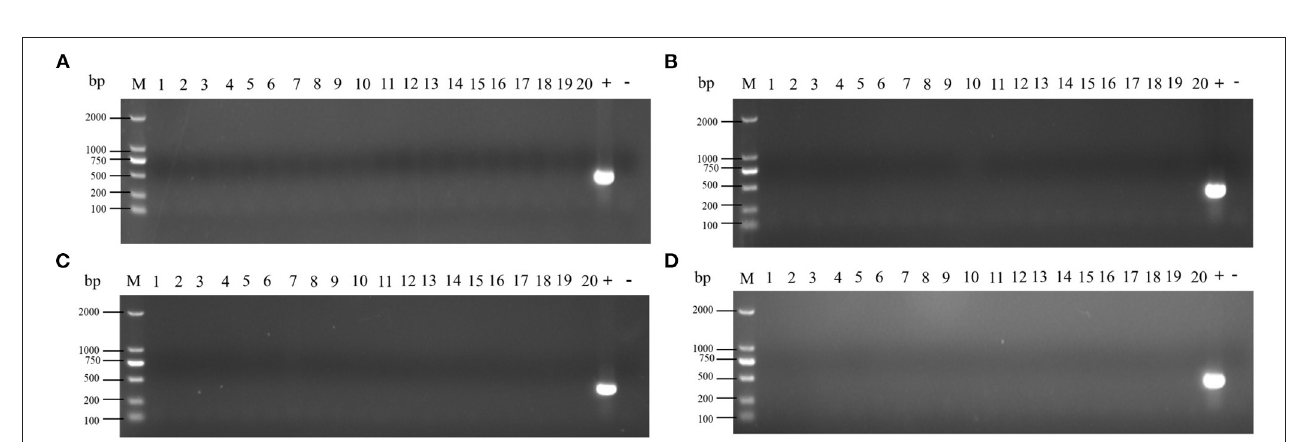
FIGURE 1 | Detection of Salmonella vaccine strains in blood from ceftiofur groups. No matter how many days after withdrawal the chicks were immunized, no Salmonella vaccine strain was detected in the blood of chickens in both the ceftiofur and control groups.